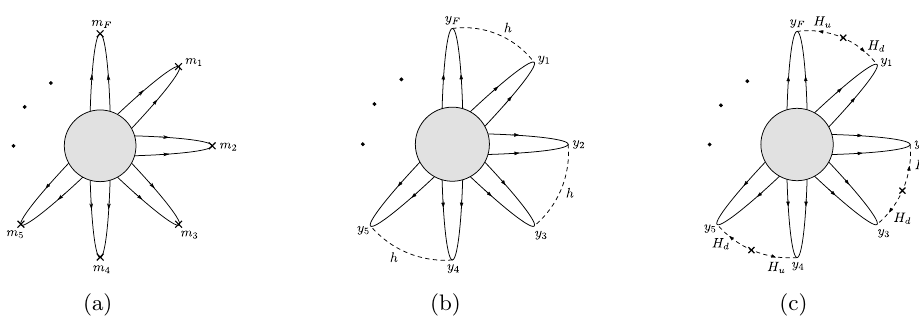
Figure 1 . Contributions to the axion mass obtained from closing up the instanton induced ’t Hooft operators. On the left we use Higgs VEV insertions, in the middle we use loops of a dynamical Higgs boson in a single Higgs theory, while on the right we use Higgs loops in a 2HDM. Note that the arrows correspond to